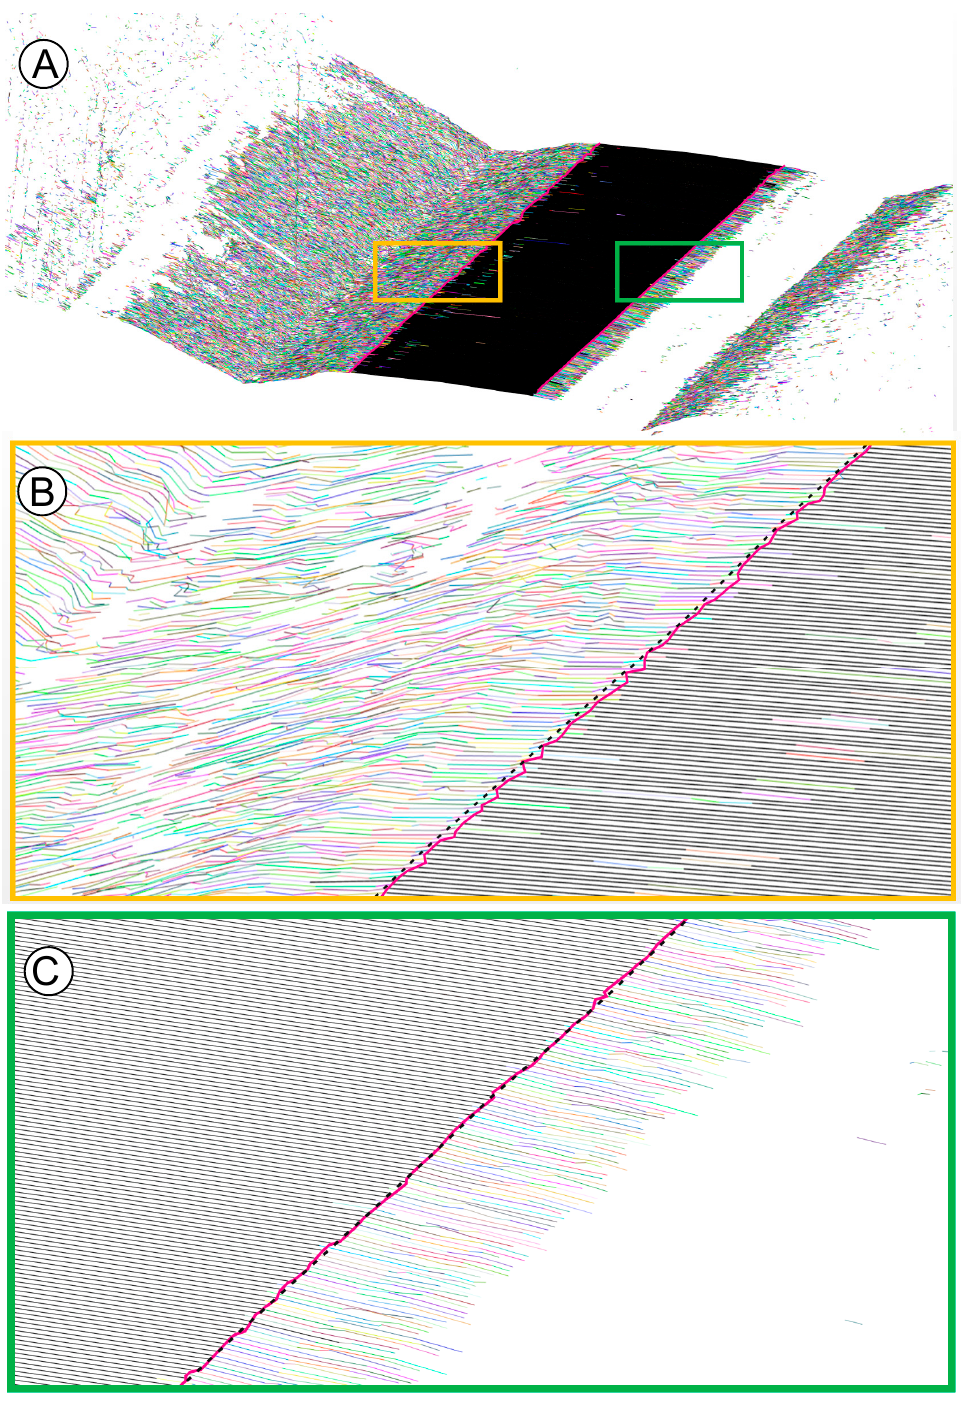
Figure 10. General view ( A ) and two zoomed details (( B ) left edge and ( C ) right edge) of the line cloud in a small road section. The algorithm-smoothed polyline is in magenta, and the RTK-GNSS ground truth is represented by a black dotted line (only visible in the zoomed windows (orange and green rectangles)). The lines belonging to the final group are in black, and the ungrouped lines in random colors.